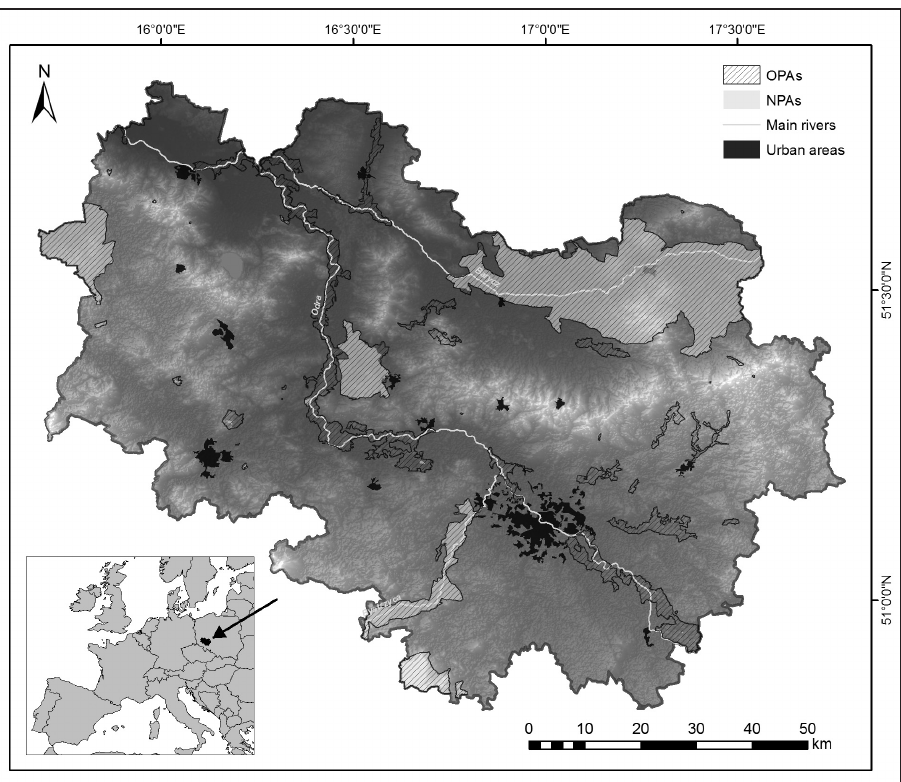
Figure 1. Study region with the network of nationally protected areas (NPAs) and overall protected areas